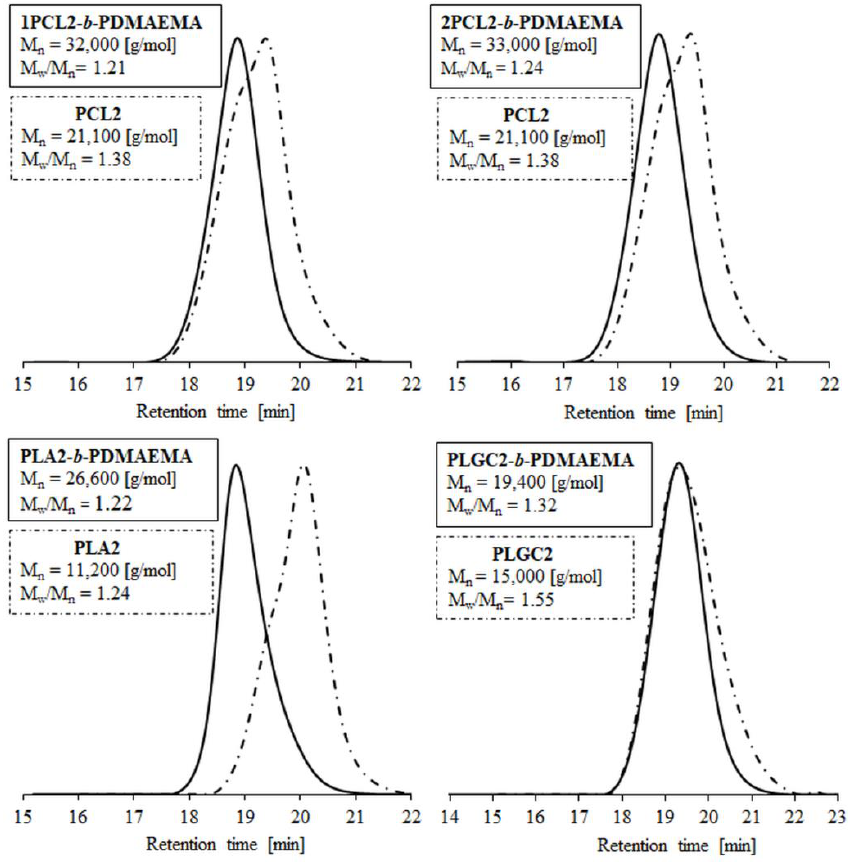
Figure 1. SEC traces of polyesters and their block polymers with PDMAEMA.